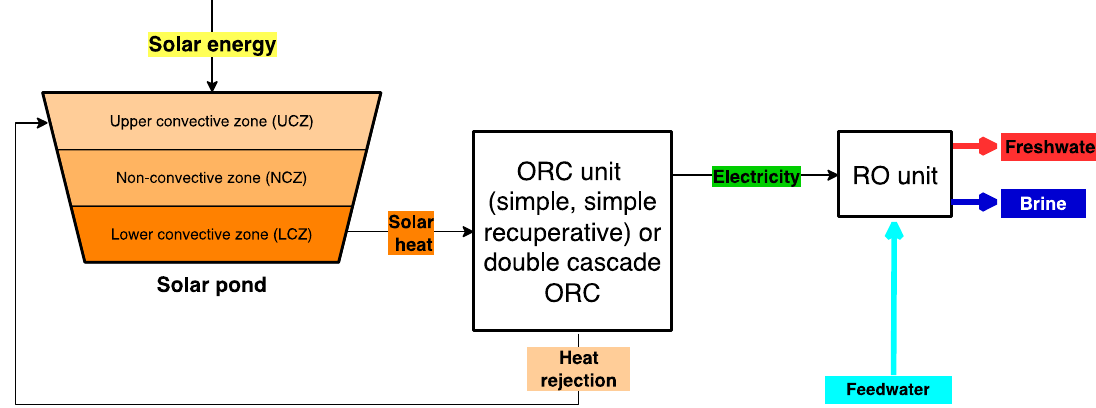
Figure 3 . General scheme of solar-pond-driven RO desalination proposals. Figure 3. General scheme of solar-pond-driven RO desalination